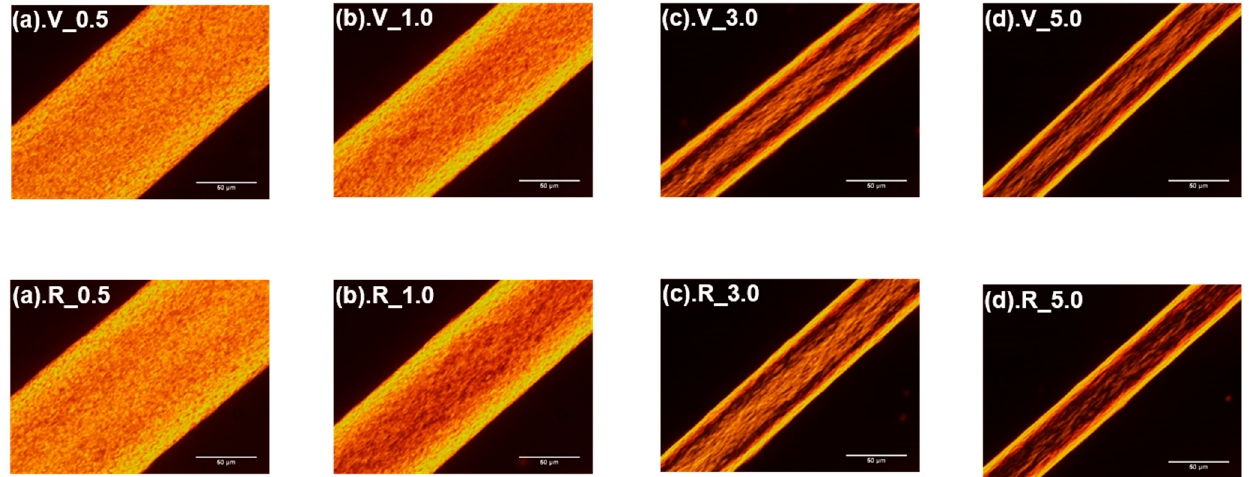
Figure 7. Optical micrographs observed under a polarizing microscope for the fibers from virgin ( upper row ) and recycled ( lower row ) PP, melt spun at different take-up velocities. The take-up velocities were ( a ) 0.5 km/min, ( b ) 1.0 km/min, ( c ) 3.0 km/min and ( d ) 5.0 km/min.